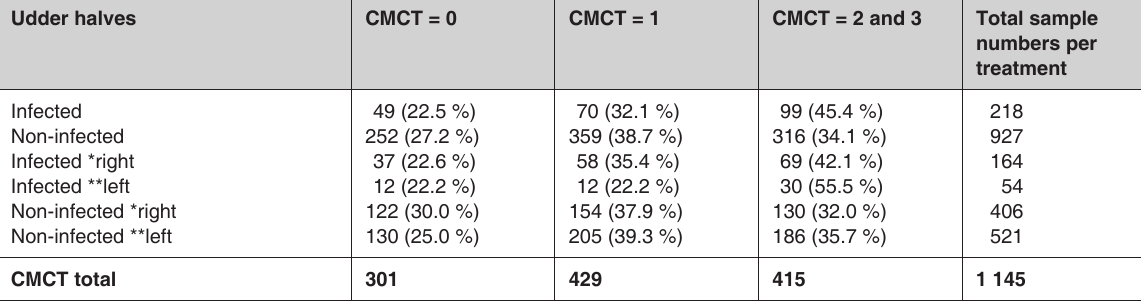
TABLE 5 California Milk Cell Test (CMCT) ratings for milk goats in different treatment groups (T1 and T2) Treatment (Rx)